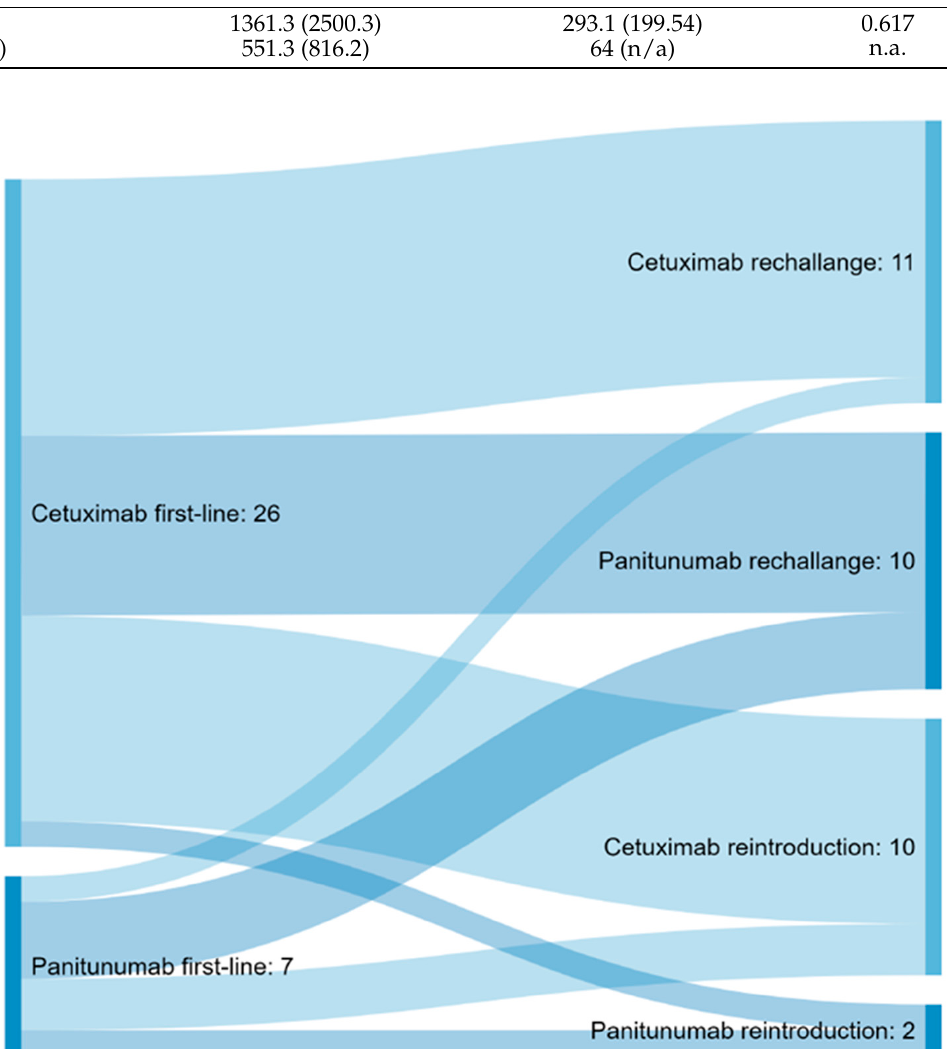
Figure 2. Sankey diagram displaying the proportional flow of patients between first anti-EGFR agent utilized in first- or second-line and anti-EGFR agent chosen for re-exposure. Patients with anti-EGFR re-exposure showed a distinct trend towards a better overall survival compared to patients without re-exposure (median OS 35.4 vs. 56 months, p = 0.06) (Figure 3). Moreover, data showed good response rates in anti-EGFR retreated patients (complete remission (CR): 21.2%, partial remission (PR): 63.6%, stable disease (SD): 9.1%, progressive disease (PD): 6.1%). Response rates of patients after first anti- EGFR exposure and anti-EGFR retreatment are displayed in Supplementary Materials Table S2. For further analysis, patients re-exposed to anti-EGFR were either assigned to a rechallenge ( n = 21, progression under anti-EGFR therapy) or reintroduction ( n = 12, anti- EGFR interruption due to other reasons) group. The analysis of these subgroups did not yield relevant differences in clinical characteristics or significant differences in survival rates (Table 3). However, patients with the anti-EGFR rechallenge showed a lower median OS in trend compared to patients with reintroduction, but the difference was not statistically significant (mOS 52.4 vs. 66.0, n.s.) (Figure 4). Similarly, median PFS for the last anti-EGFR-based therapy showed a trend towards a shorter mPFS in the rechallenge patients compared to the reintroduction patients without statistical significance (3.68 vs. 7.33 months, n.s.).